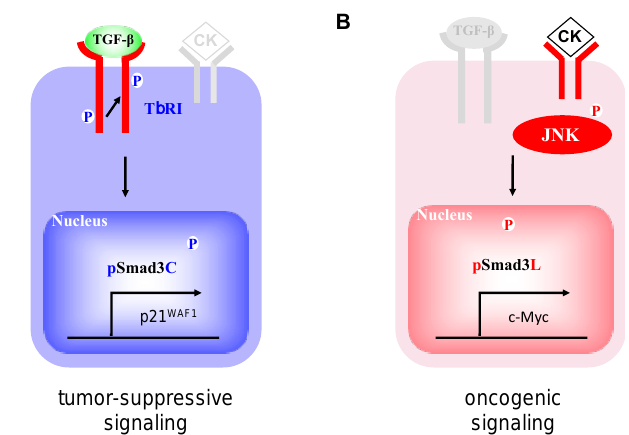
Figure 1. Smad3-dependent signaling between two distinct phospho-isoform. ( A ) Catalytically active TGF- βtype I receptor ( T β RI) phosphorylates C-terminal region of Smad3. pSmad3C interferes with cell-cycle progression by transcriptional activation of p21 waf1 in the nucleus. ( B ) Pro-inflammatory cytokines (CK) activate c-Jun N-terminal kinase (JNK), resulting in phosphorylation of Smad3 at linker domain. pSmad3L promotes hepatocyte proliferation and hepatic carcinogenesis by up-regulating c-Myc transcription in the nucleus.